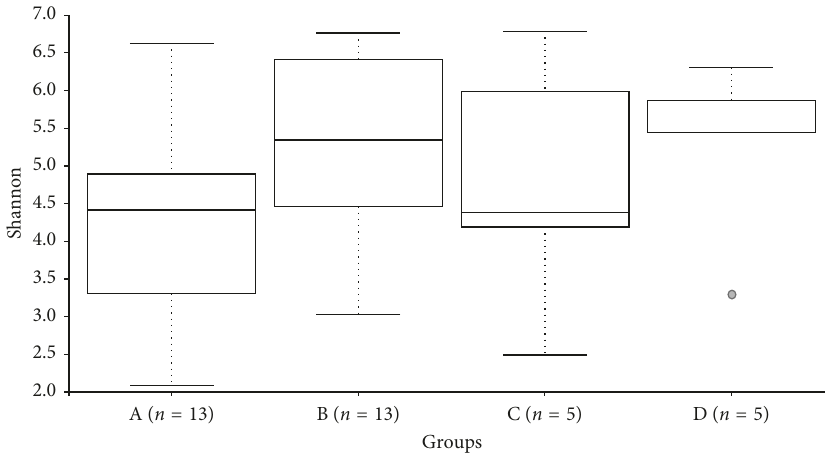
Figure 4: Shannon diversity